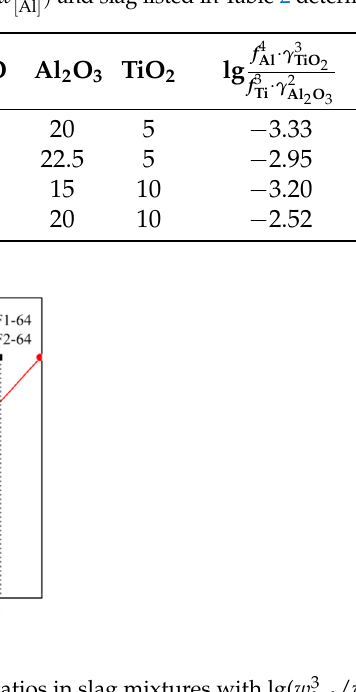
(cid:16) (cid:17) w 3 / w 4 = 5.03 or [ Al ] [ Ti ]